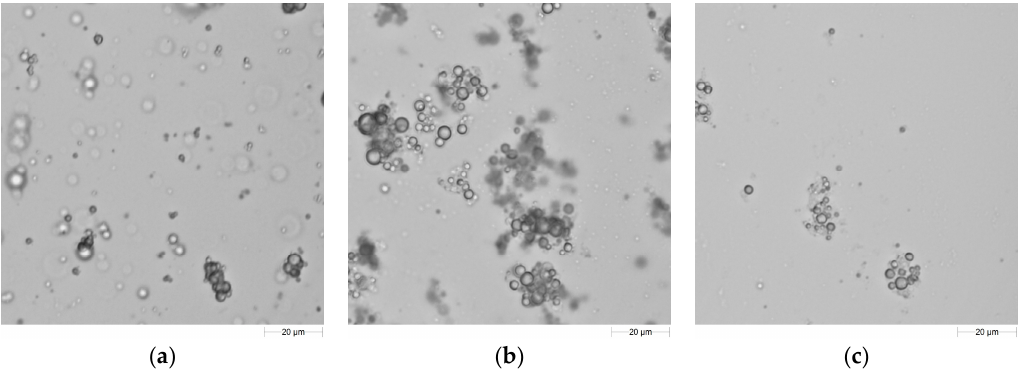
Figure 8. Digitized microscope images obtained from different formulations: ( a ) Formula 1: 1.25% sodium alginate + 2% glycerol + 0.2% sunflower oil + 1% span 80; ( b ) Formula 2: 1.25% sodium alginate + 2% glycerol + 0.2% sunflower oil + 1% span 80 + 0.2% tween 40; ( c ) Formula 3: 1.25% sodium alginate + 2% glycerol + 0.2% sunflower oil + 1% span 80 + 0.2% tween 80. Solutions were not